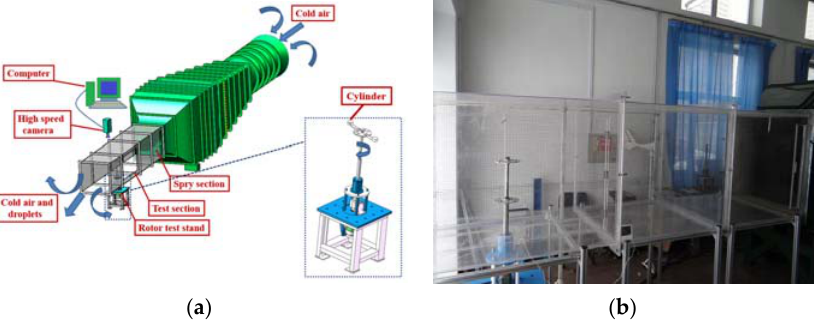
Figure 3. Icing wind tunnel experimental system. ( a ) Experimental system; ( b ) picture of the test section.